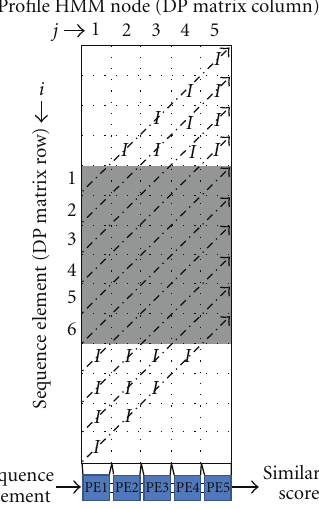
Figure 5: PE to DP matrices correspondence when the HMM number of nodes is less or equal to the number of